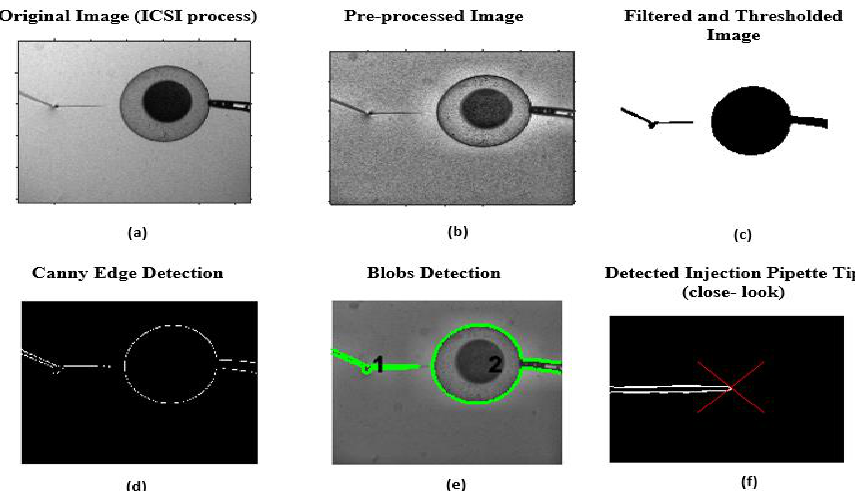
Figure 4. Steps in vision-based positional detection of the injection pipette: ( a ) original ICSI image captured by the camera; ( b ) image after implementation of the CLAHE method; ( c ) ICSI image after application of Gaussian filter and adaptive thresholding; ( d ) extraction of the contour information of the ICSI image using canny edge detection algorithm; ( e ) recognition of the egg and injection pipette and distinguishing them based on their blobs feature; ( f ) detection of the injection pipette tip indicated by red